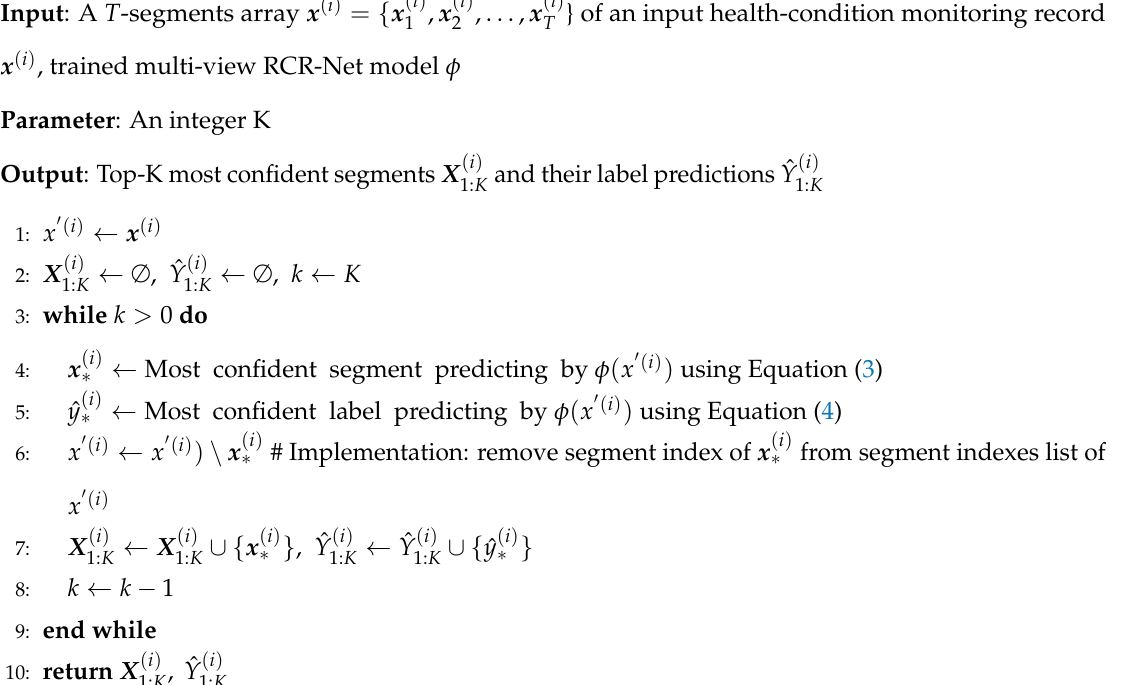
Algorithm 1 K-margin( x ( i ) , K , φ